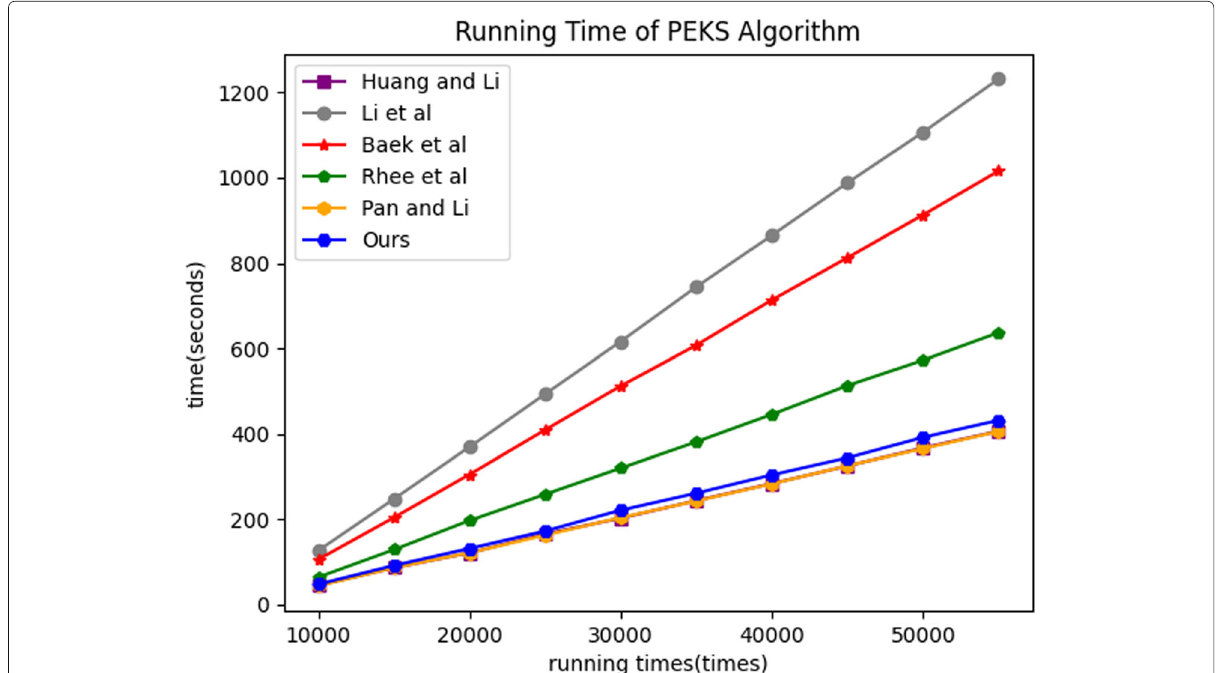
Fig. 2 Running Time of PEKS